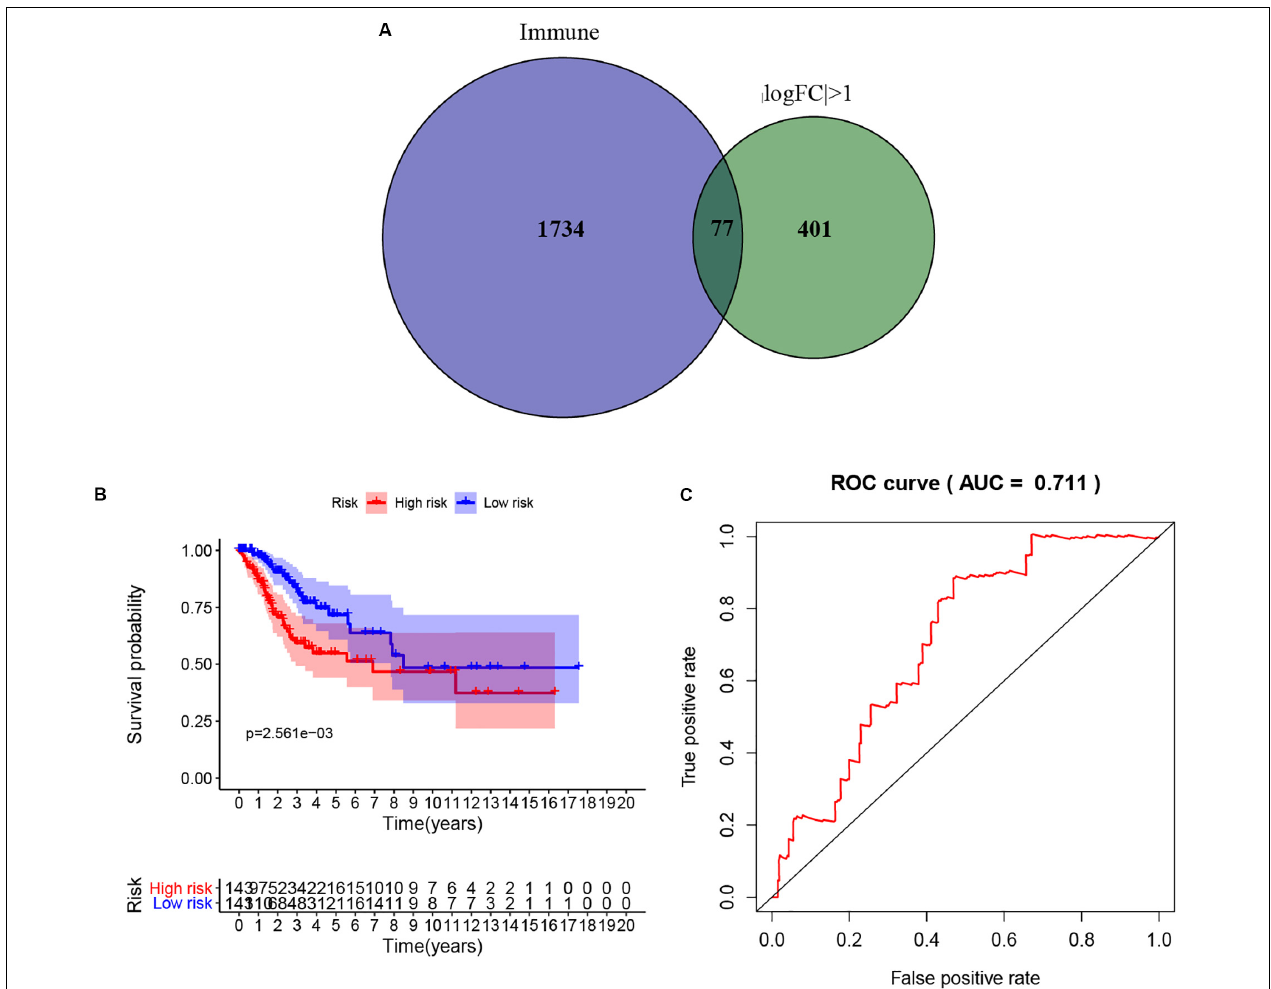
FIGURE 7 | Prognostic model based on the hub TMB-related immune genes. (A) Screening of TMB-related immune genes. (B) Kaplan-Meier curves of OS for low- and high-risk group ( p = 0.003). (C) ROC curve for judging the accuracy of model predictions (AUC = 0.711). TMB, mutant tumor burden; OS, overall survival; ROC, Receiver operating